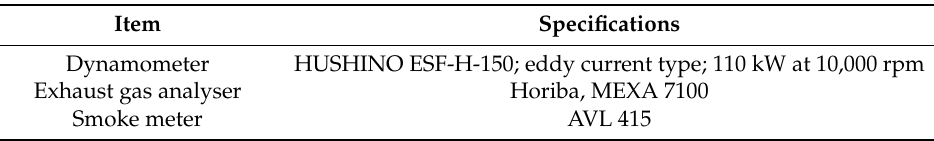
Table 4. Specifications of the engine dynamometer and exhaust analyser.